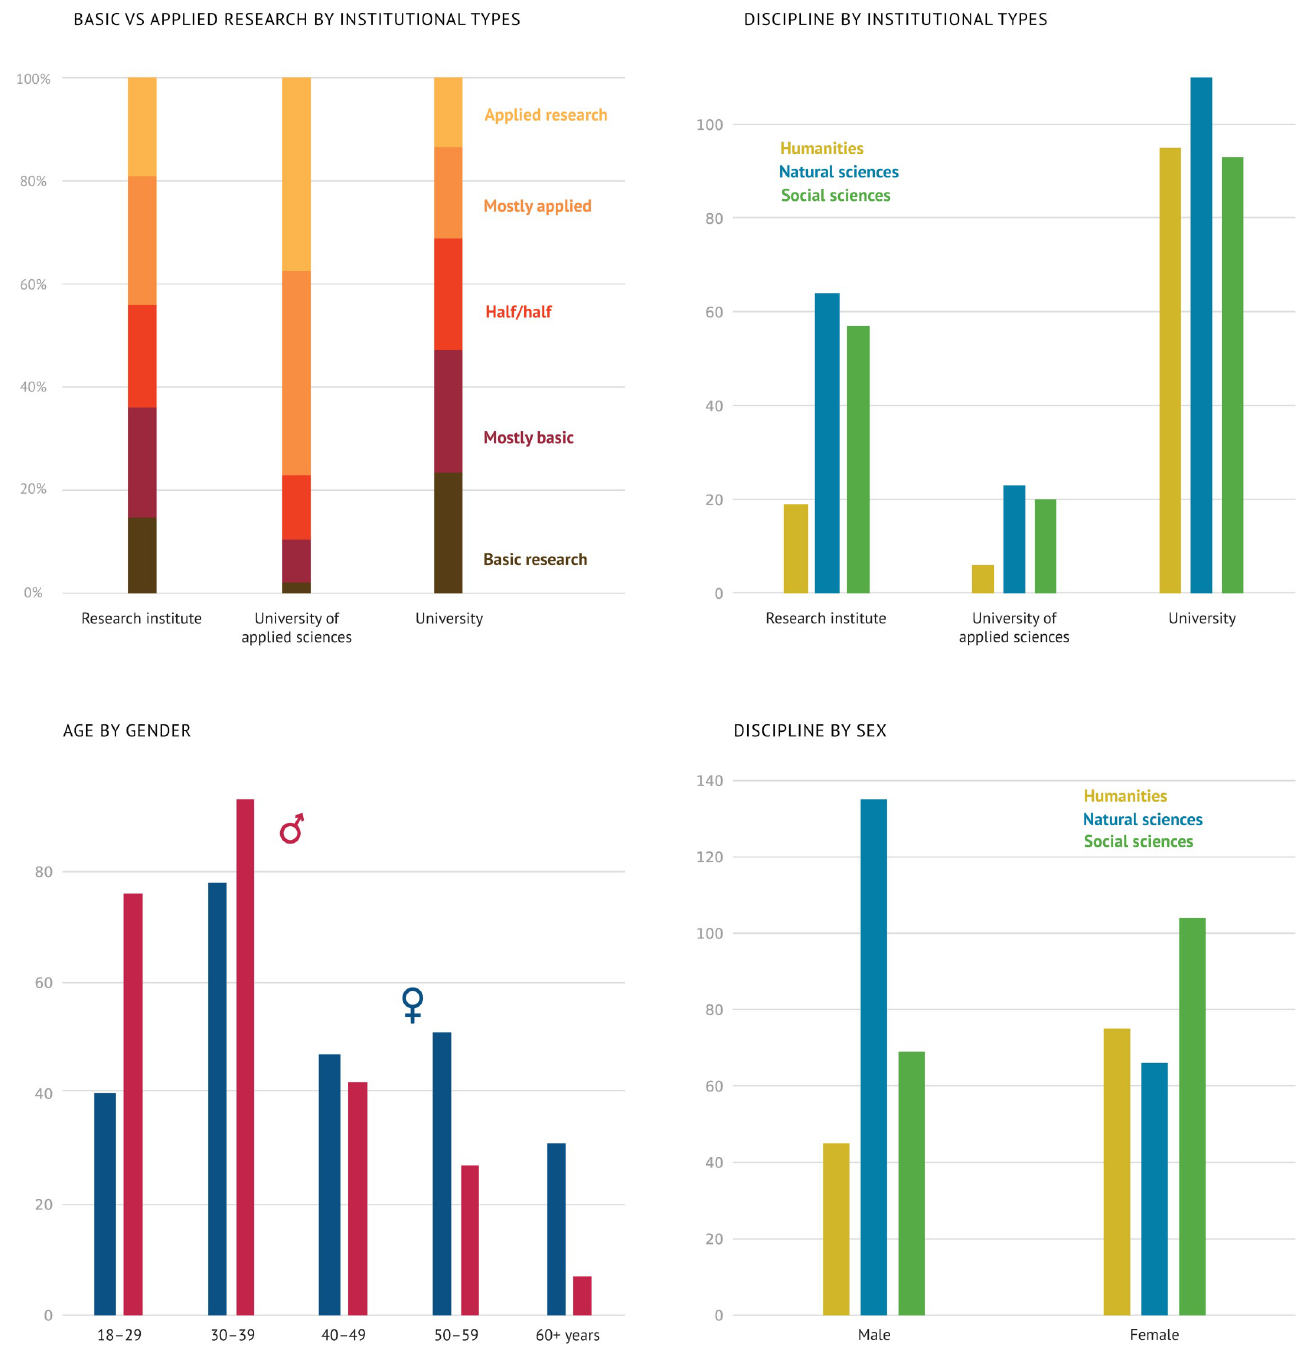
Fig 1. Description of the sample using the explanatory variables that are at the core of our analysis. (1) To what extent do researchers from the three disciplinary groups (natural sciences, social sciences, and humanities) consider their work as basic or applied research? (2) Distribution of the disciplinary groups across the prevailing institutional types. (3) Distribution of the researchers’ sex across age groups. (4) Distribution of disciplinary groups for male and female researchers. The number of participants with other sex was so small that they were not included in these graphs.